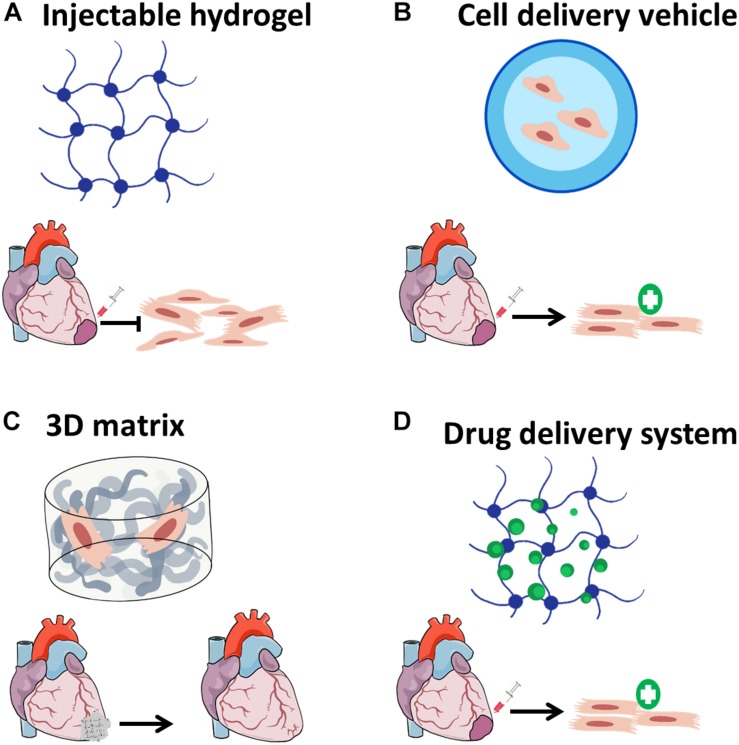
Biomaterial-based applications for cardiac tissue engineering. (A) Biomaterials can be injected alone into the infarcted regions in order to attenuate scar formation, (B) cell-delivery using injectable hydrogels can improve cell retention and survival after transplantation; (C) three-dimensional matrices can be fabricated with or without cells, then implanted as cardiac patches to improve cardiac function; and (D) biomaterials designed to release drugs and bioactive molecules may induce cardiac regeneration in a sustained effective manner.